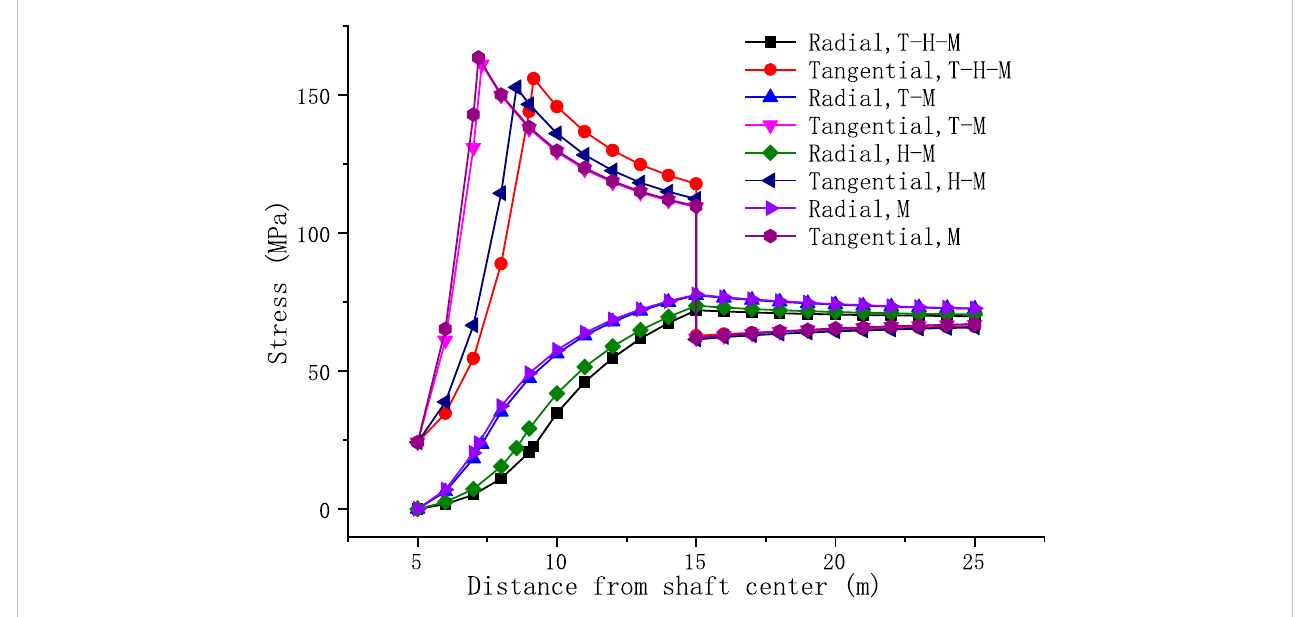
FIGURE 2 Stress distribution of surrounding rock under the combination of thermo-hydro-mechanical